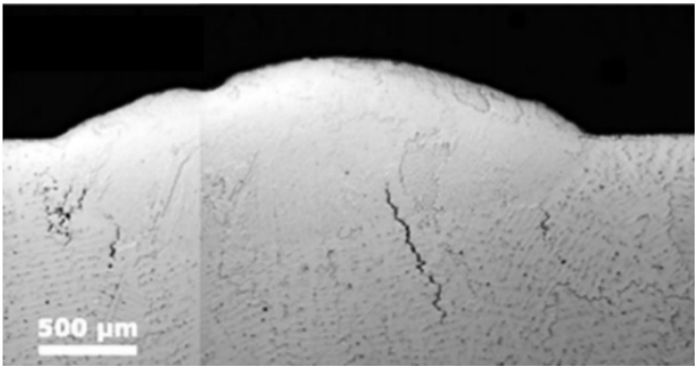
Figure 19. The clod cracks in HAZ of the CM-247LC substrate (the laser power is 1000 w, and the scanning speed is 199 mm/min)